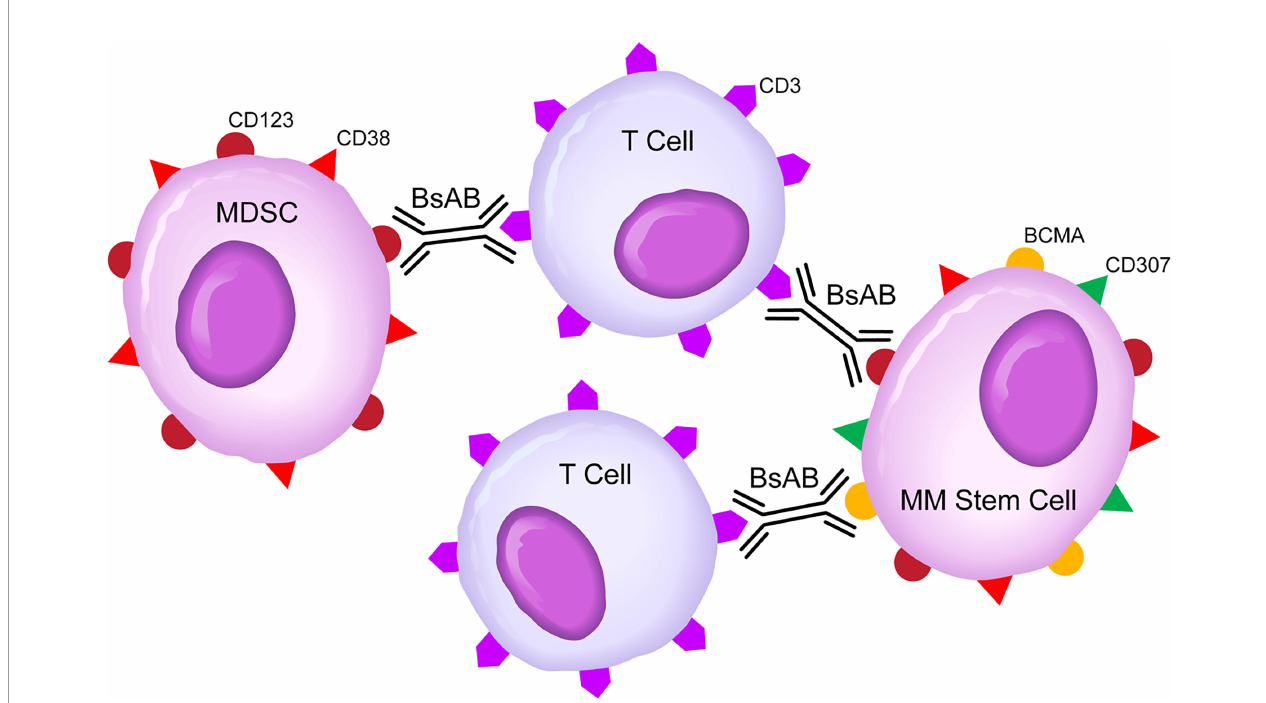
FIGURE 3 | Bispeci fi c CD3xCD123 Antibodies For Dual Targeting of MM Stem Cells Clones and MDSC Cells in High-Risk MDS Patients. BsAB, bispeci fi c antibody; MM, Multiple myeloma; MDSC, Myeloid-derived suppressor cell. See text for a detailed discussion of the rationale of targeting the CD123 and CD38 antigens that are expressed on both MM stem cell clones and